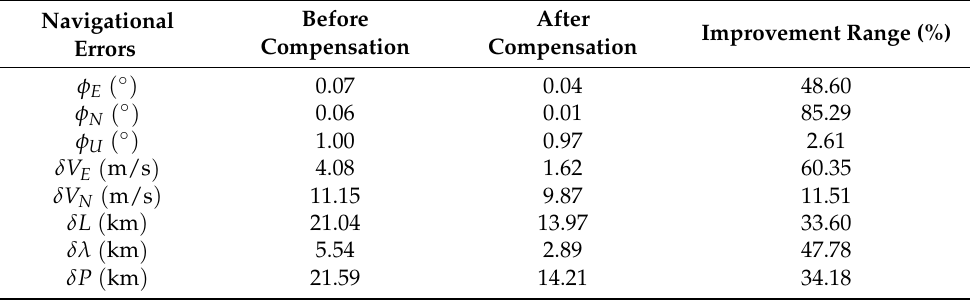
Table 4. Simulation results of attitude angle error, velocity error, and position error.